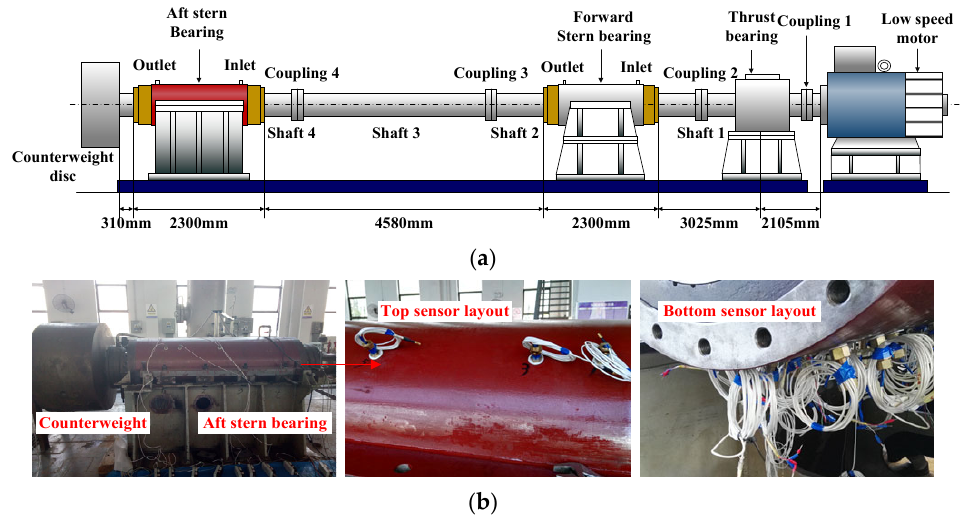
Figure 1. Test rig: ( a ) schematic of the structure and ( b ) test bearing. The stern bearing, including the lining and the sleeve, is the test bearing. The bearing structure is shown in Figure 2. The sleeve material is stainless steel, and the lining is a polymer composite material with a modulus of elasticity of 2320 MPa, Poisson’s ratio of 0.327, and density of 1300 kg ∙ m –3 . Both sides of the lining have a lateral groove with radius r , and the distance between the centers of the lateral groove and the bearing is e . The bear ‐ ing length ‐ to ‐ diameter ratio is 3.7, and the shaft diameter is 323 mm. In the figure, l 1 is the